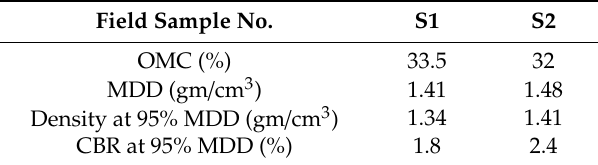
Table 6. California Bearing Ratio (CBR) values of the natural soil samples. Field Sample